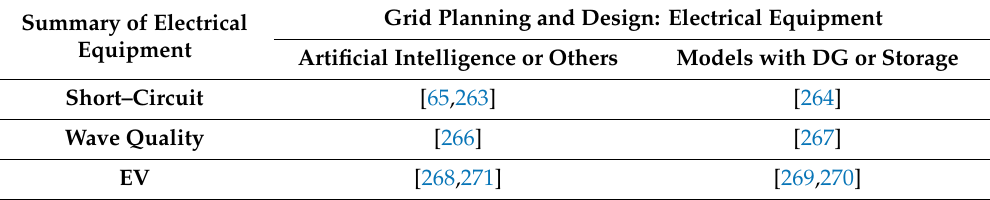
Table 12. Summary of Electrical Equipment